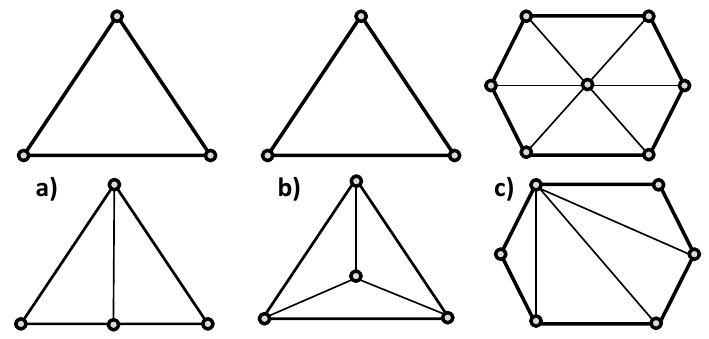
Figure 2c. In region collapses, one, two, or three faces bounding the region to collapse are removed to combine elements.